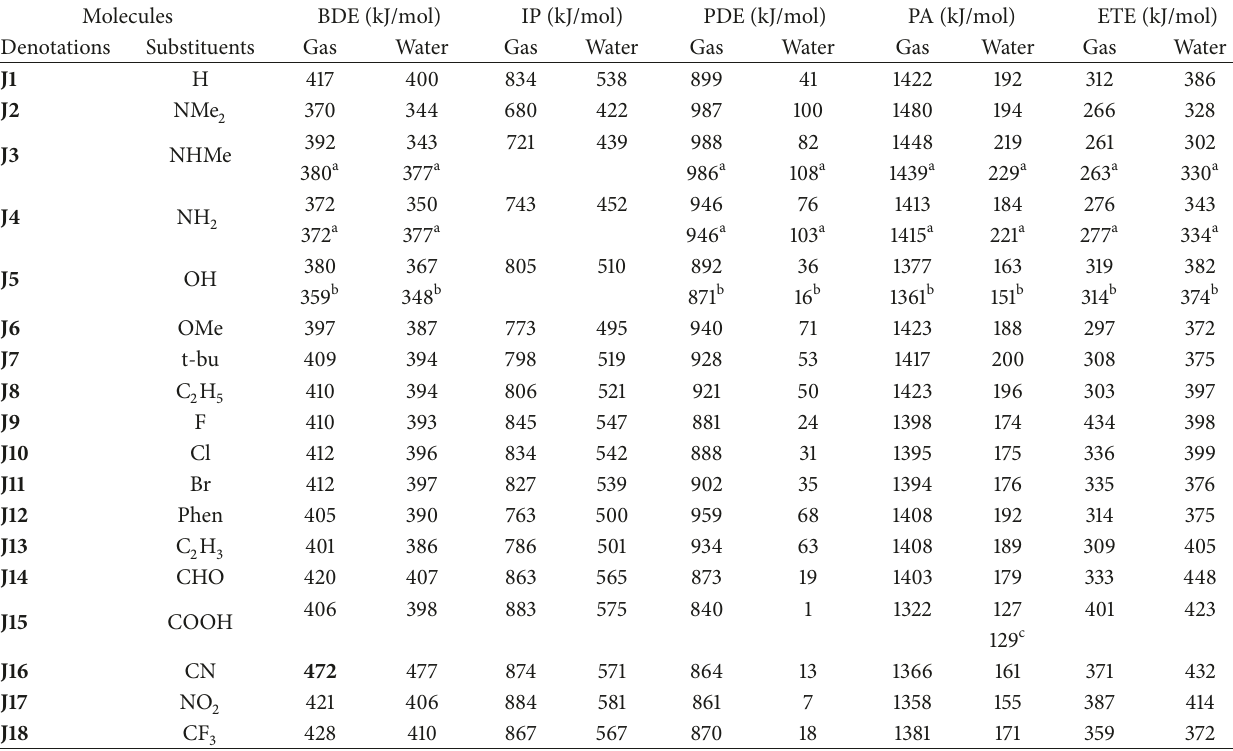
Table 1: Thermodynamic energies in kJ/mol: bond dissociation energies, ionization potential, proton dissociation energies, proton affinities, and electron transfer energies in gas phase and in water at B3LYP/6-31+G(d,p) level.